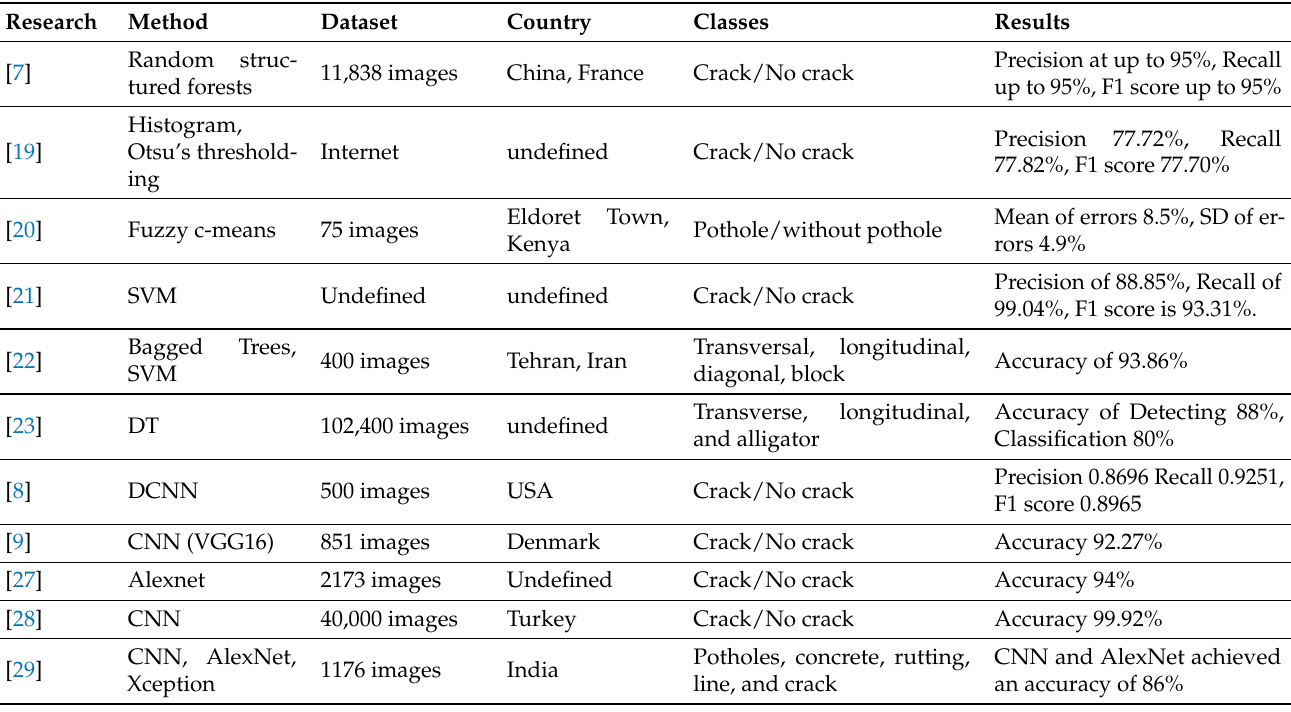
Table 1. Summary of ML and DL